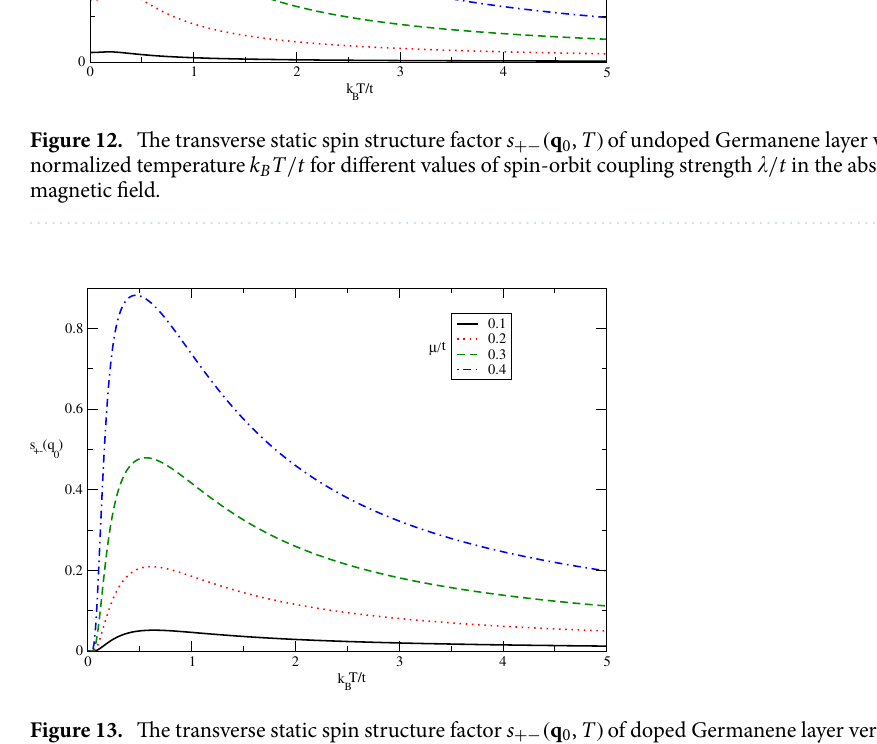
Figure 13. The transverse static spin structure factor s temperature k B T / t for different values of chemical potential µ/ t in the absence of magnetic field with spin-orbit 0.3 coupling (cid:31) / t =